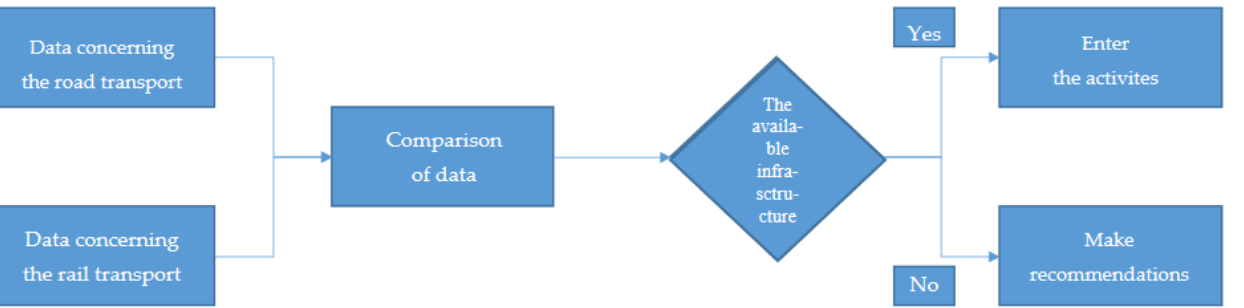
Figure 1. The general method of analysing is taking advantage of the potential of road and rail transportation.